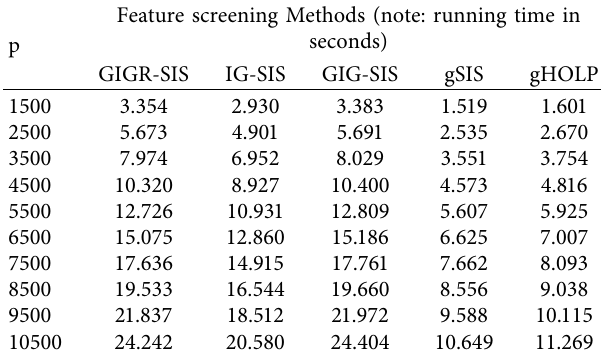
Table 7: Simulation results for Model